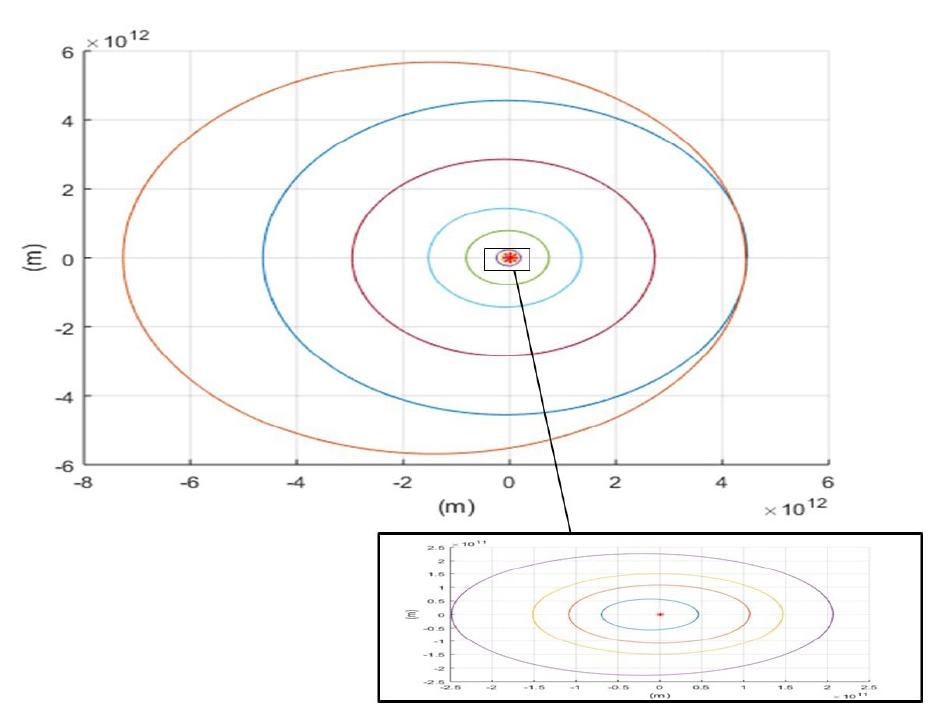
Figure 2. Closed - bound planet trajectories with and without Yukawa correction with nominal strength α